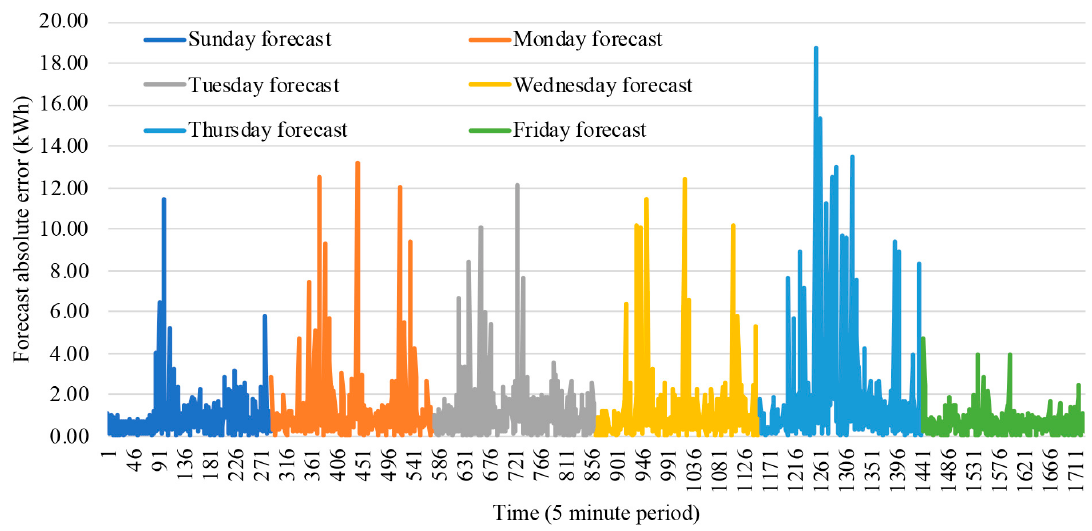
Figure 8. Consumption forecast errors for period 8 to 13 April 2019.